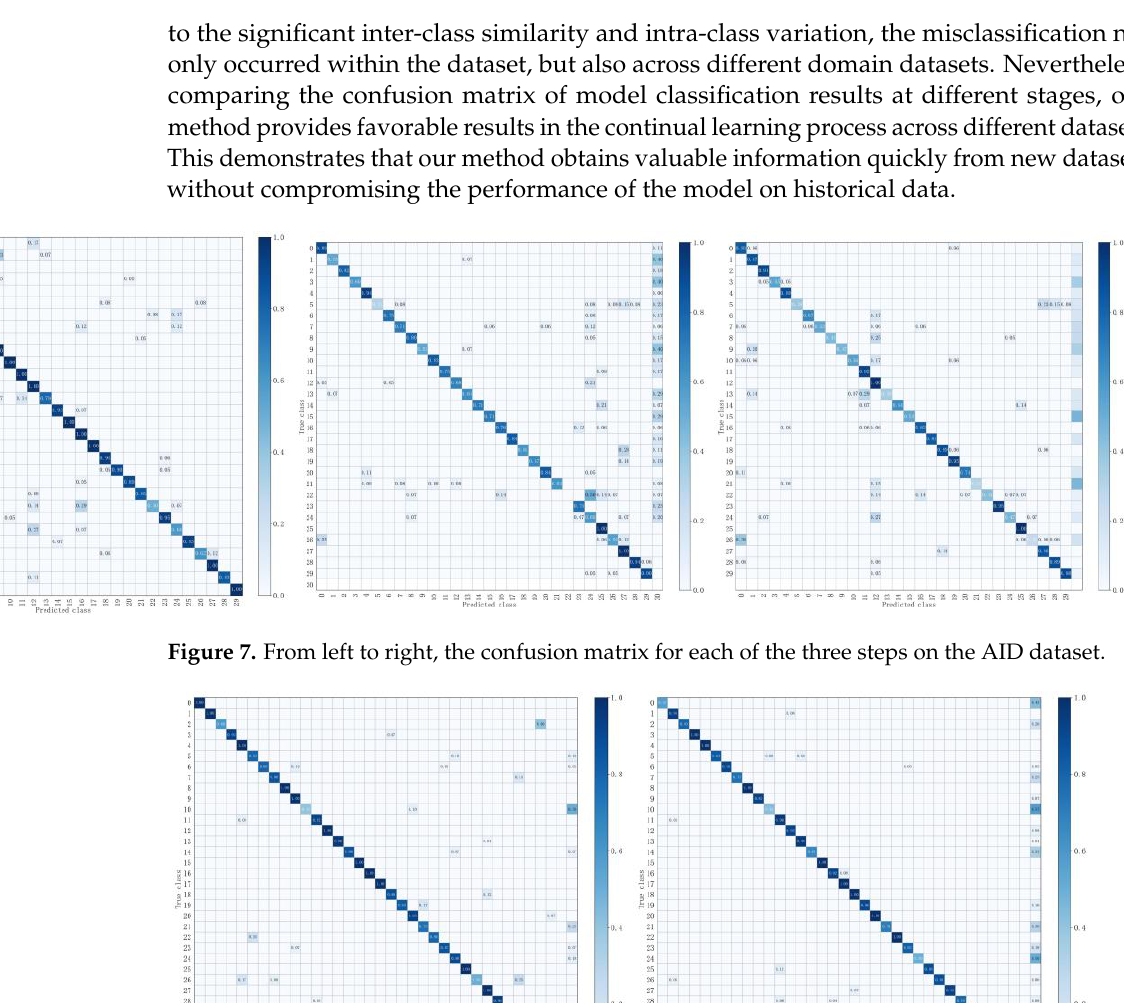
Figure 9. The confusion matrix of third step task on NWPU dataset.